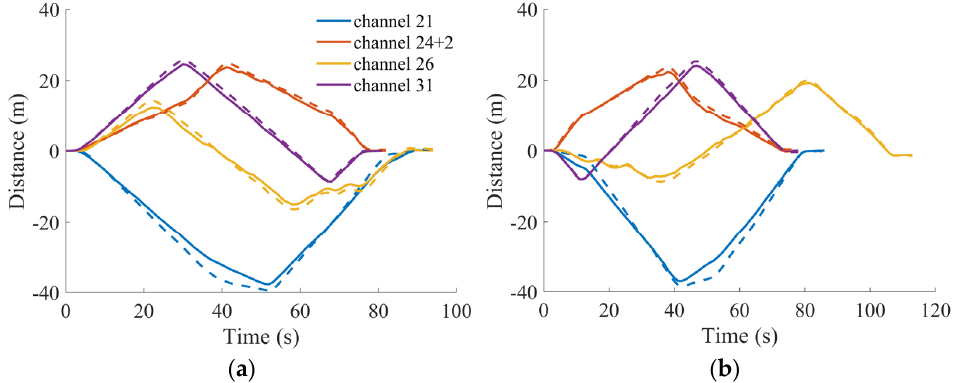
Figure 9. Carrier phase ranging in dynamic scenario, ( a ) clockwise, ( b ) counter-clockwise. The corresponding error cumulative distribution function (CDF) is plotted in Figure 10, where the maximum ranging error is below 2.2 m for channel 24+2, 26, and 31. A large error occurred in channel 21 because of the deviation in 20~60 s in Figure 9a, and 40~80 s in Figure 9b. The reason for the large error in this channel was discussed before.